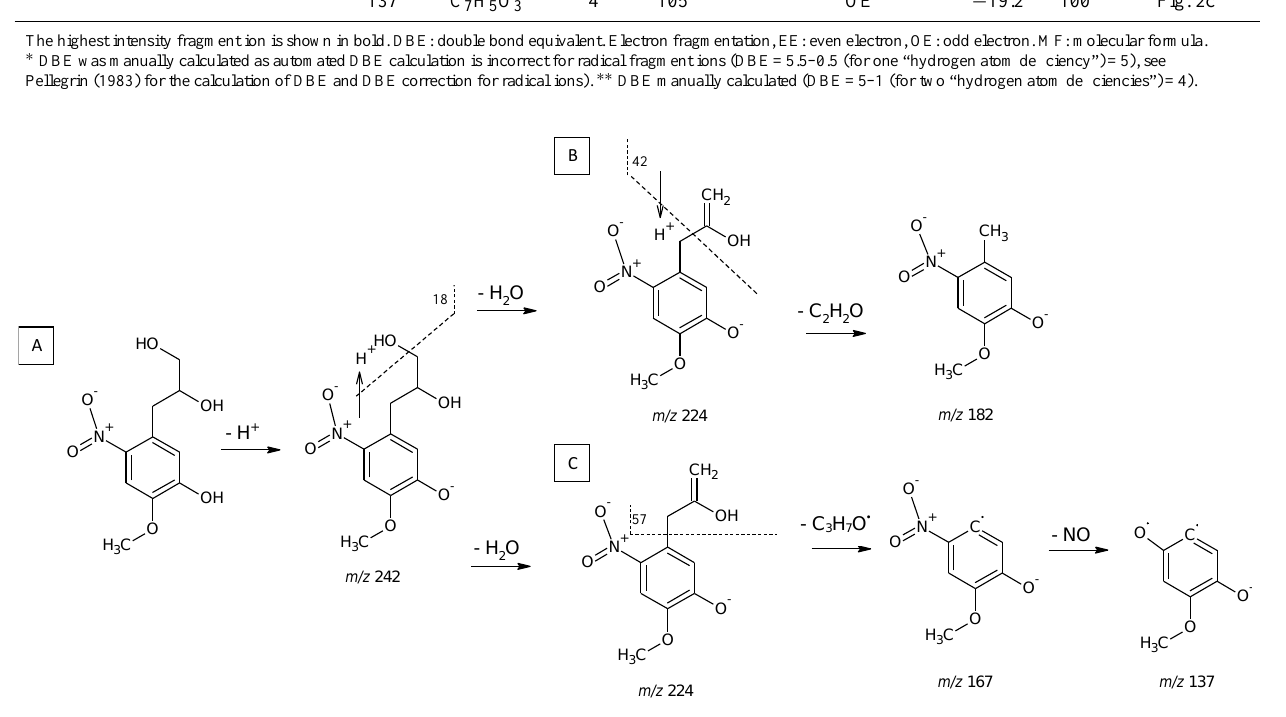
Figure 2. Proposed deprotonated molecular species fragmentation for compound 1 in negative ionisation mode. Dashed lines indicate the location of